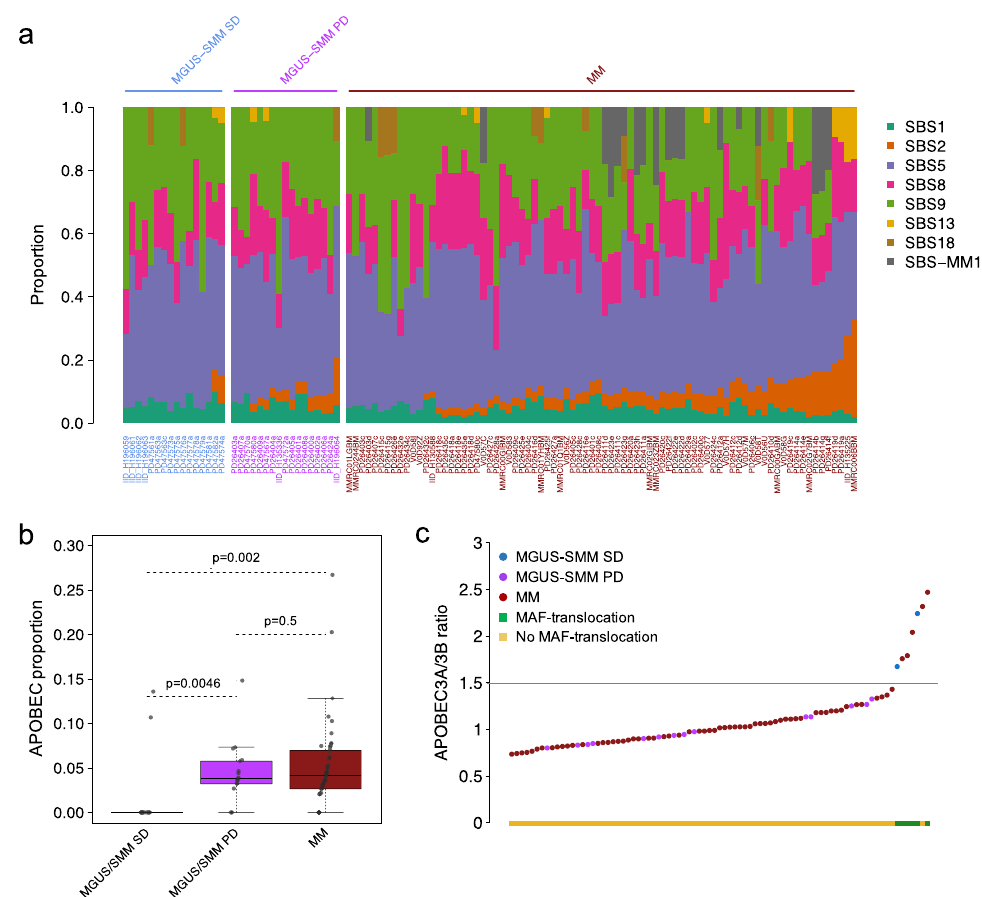
Fig. 2 Mutational signature landscape of multiple myeloma (MM) and myeloma precursor condition. a Mutational signature contribution across all WGS samples included in the study. PD47563 is a patient with stable myeloma precursor condition with two samples collected at different time points, both reported in this plot (i.e., PD47563a and PD47563c). b Comparison of APOBEC mutational contribution (SBS2 + SBS13) between MM ( N = 80), progressive ( N = 17), and stable myeloma ( N = 15) precursors. p values were calculated using Wilcoxon rank-sum test. Boxplots show the median and interquartile range. c APOBEC3A:3B ratio of all patients included in the study having detectable APOBEC activity. Blue, purple, and brown dots represent stable, progressive myeloma precursors, and MM, respectively. The green and yellow boxes on the x -axis re fl ect cases with and without translocations involving MAF / MAFB , respectively. MM: multiple myeloma, MGUS: monoclonal gammopathy of undetermined signi fi cance, SMM: smoldering